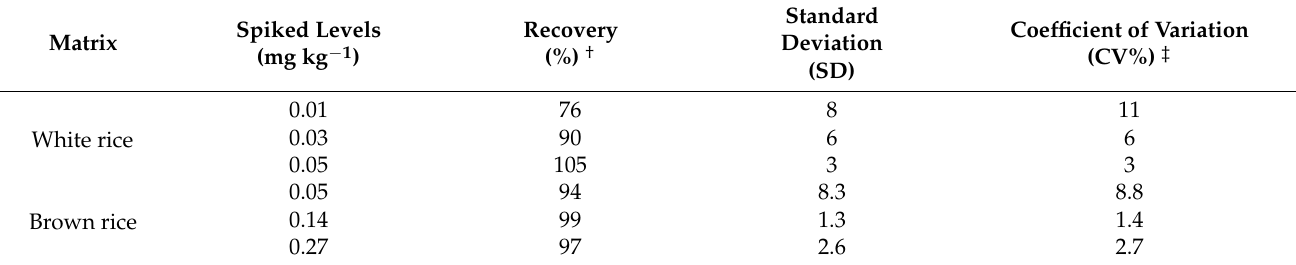
Table 1. Average recoveries (%), standard deviation (SD), and coefficient of variation (CV%) at different spiked levels of the extracted solution from white and brown rice. † Three replicates for each level. ‡ Five replicated samples at each fortification